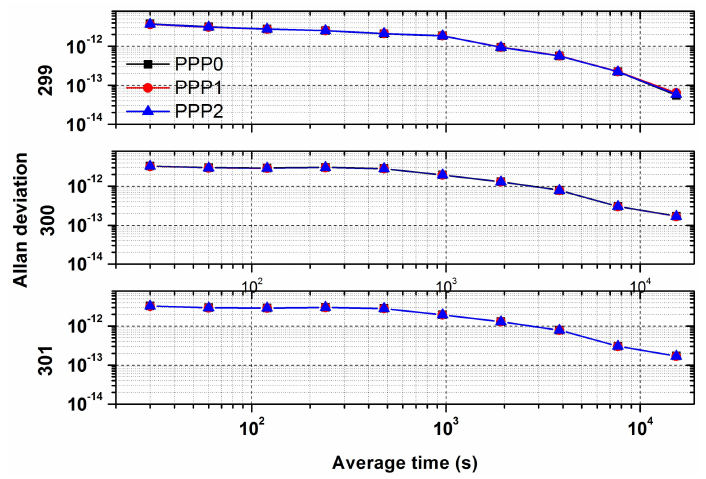
Figure 7. Comparison of Allan deviation between different models.